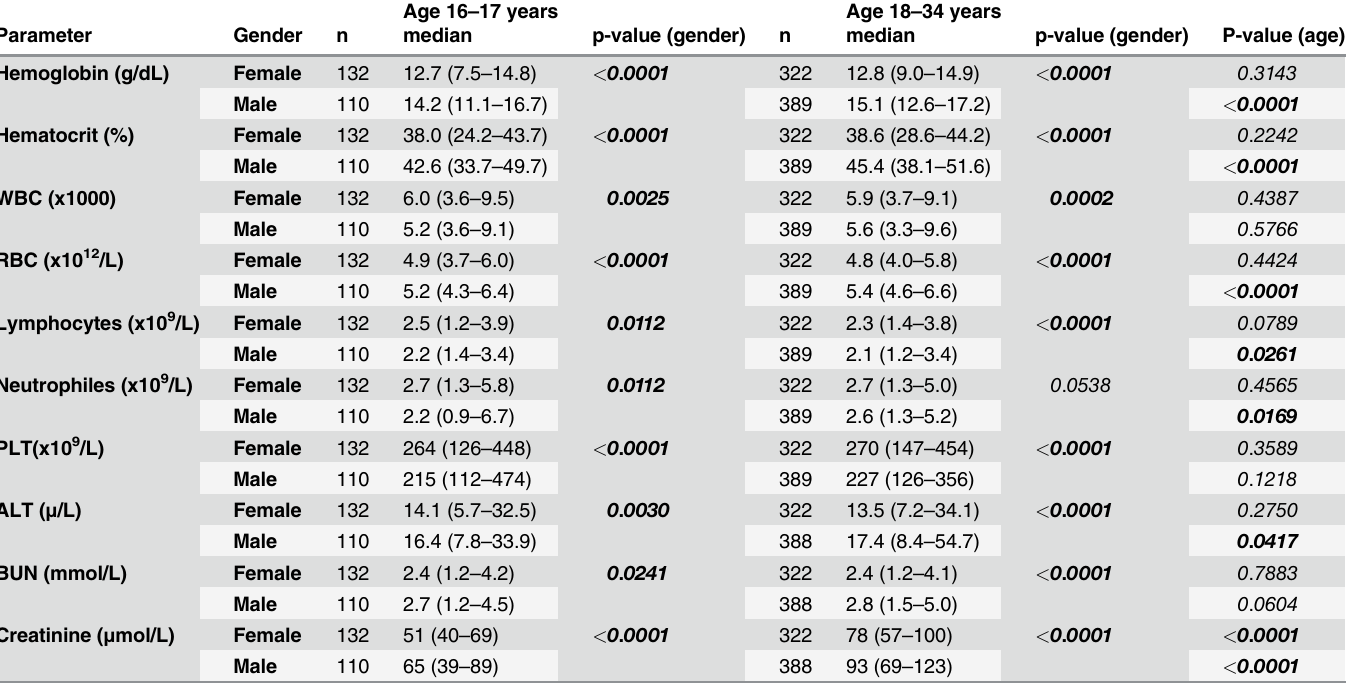
Table 4. Test of difference in hematologic and clinical chemistry parameters between gender and age-groups from the 16 – 34 years old cohort in Kisumu Kenya (2007 –